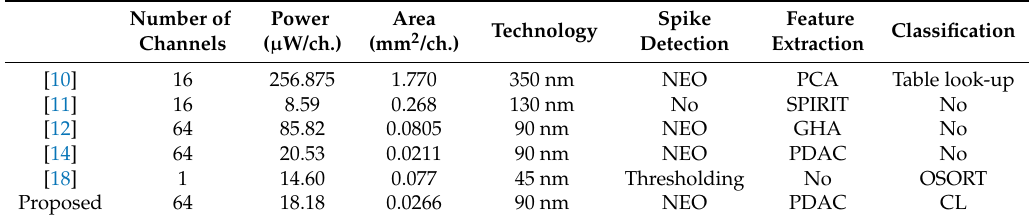
Table 7. Comparisons of various ASIC implementations for spike